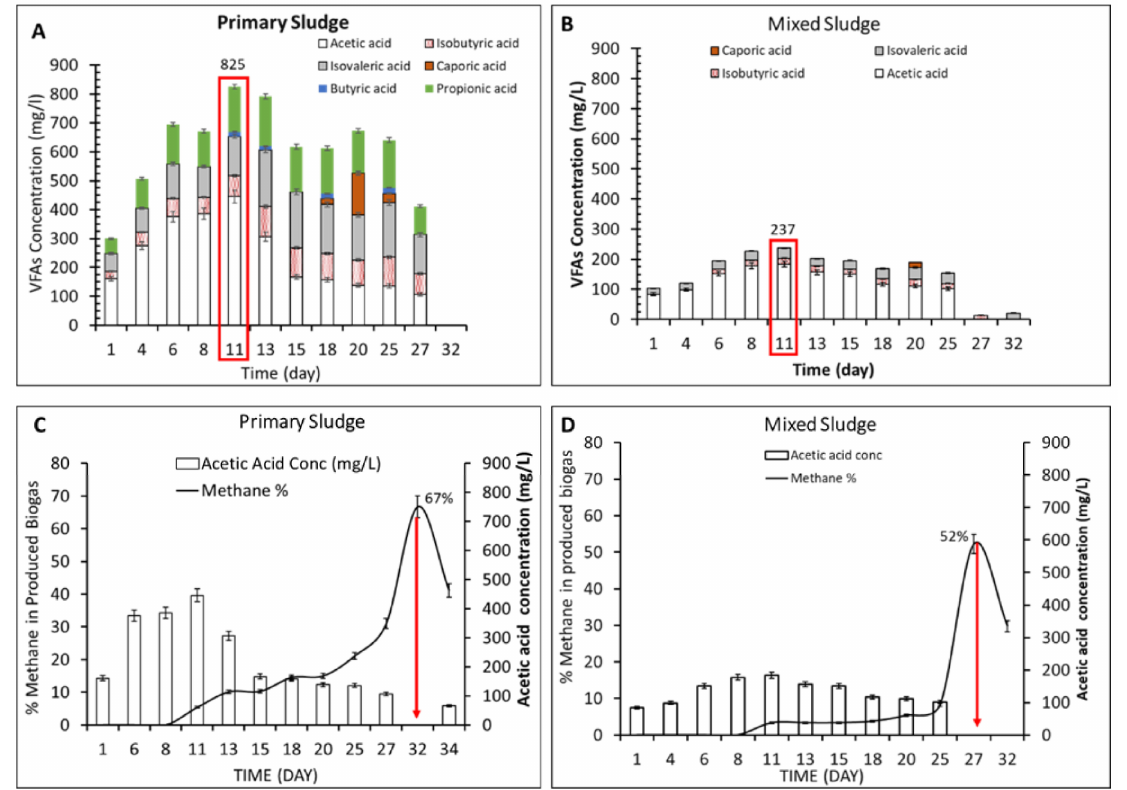
Figure 2. The effect of VFAs accumulation on methane production (%) in biogas for TAD process; ( A ) VFAs accumulations in TAD with primary sludge, ( B ) VFAs accumulations in TAD with mixed sludge, ( C ) Methane production (%) with primary sludge, ( D ) Methane production (%) with mixed sludge; Red square mark highlighted the day of maximum total VFAs and Red arrow mark showed the day of maximum